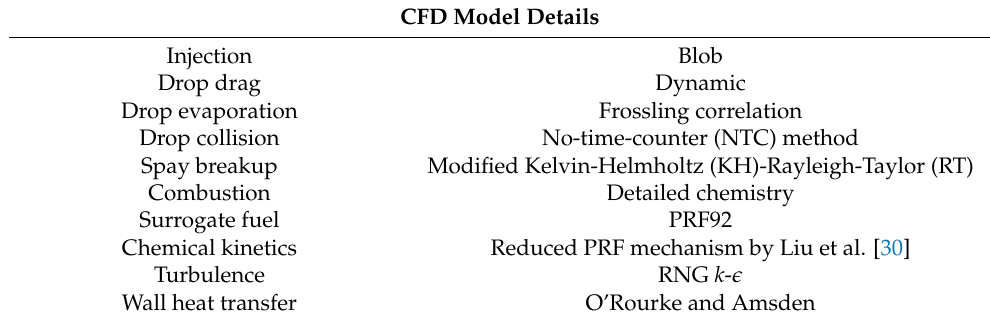
Table 4. CFD model